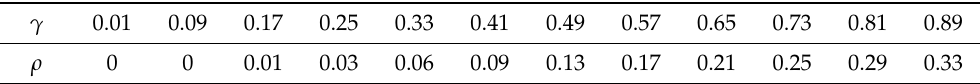
Table 13. Values of the rho of Spearman of the TGCC copula for θ = ( γ ,1/ γ ,1/ γ ) and several values of γ ∈ ( 0,1 ] , belonging to Configuration 1.